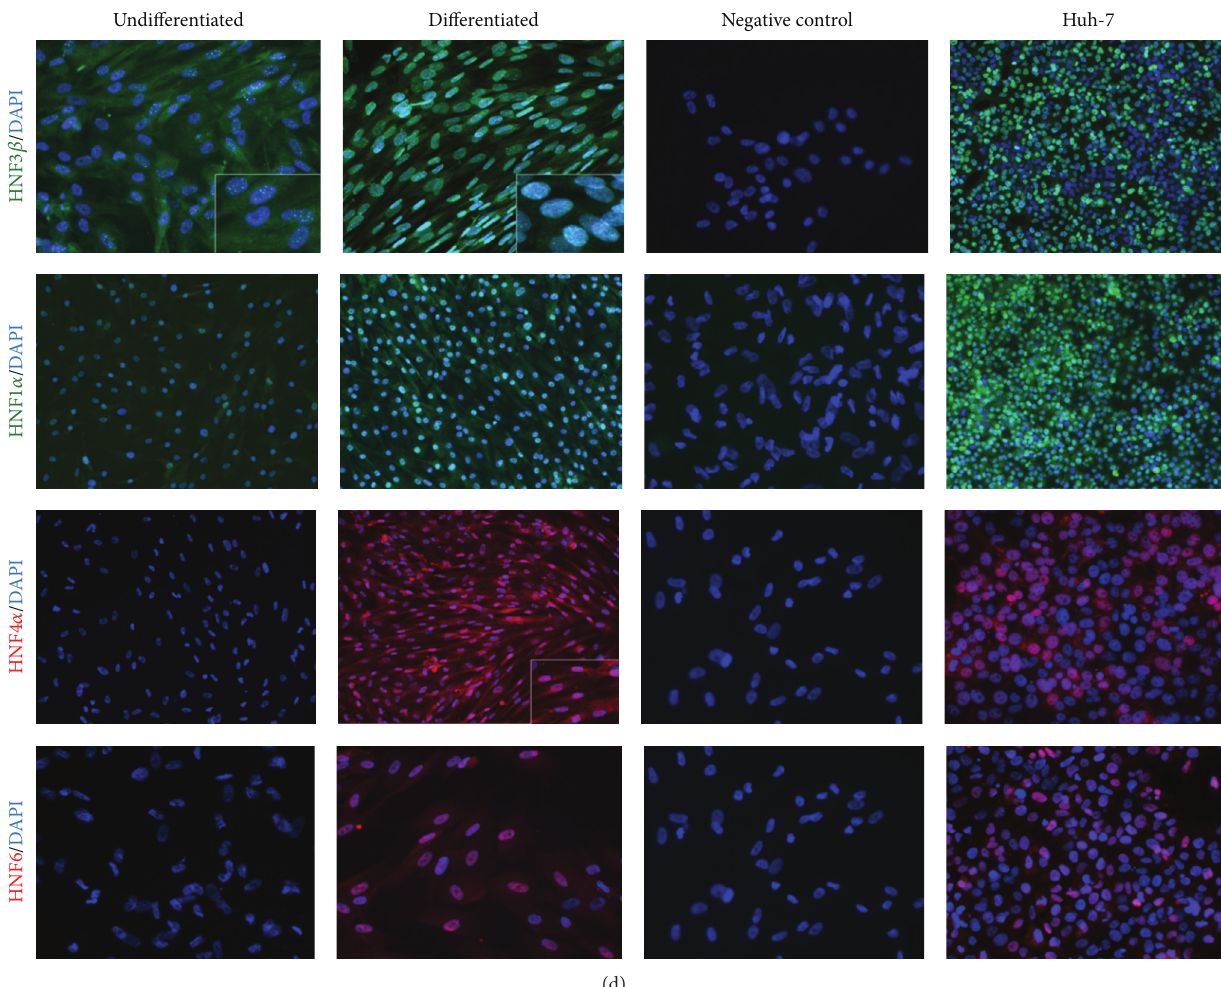
Figure 4: In vitro hepatocytic differentiation of FL-MSCs. (a) Morphological changes noticed in differentiated FL-MSCs after 3-4 weeks of culture in hepatogenic differentiation medium as compared to undifferentiated cells. Magnification: 100x. (b) RT-qPCR gene expression analysis demonstrated the decrease in stemness markers and the upregulation of hepatocyte markers mostly at the last maturation step of the differentiation process which is in correlation with morphological changes. Results are expressed as fold change in differentiated versus undifferentiated FL-MSC. ALB (albumin encoding gene), MRP2 (multidrug resistance-associated protein-2 encoding gene), FOXA1 (Forkhead Box A1 encoding gene), ACTA2 ( 𝛼 -SM-actin encoding gene), CDH1 (cadherin-1 encoding gene), CXCR4 (chemokine